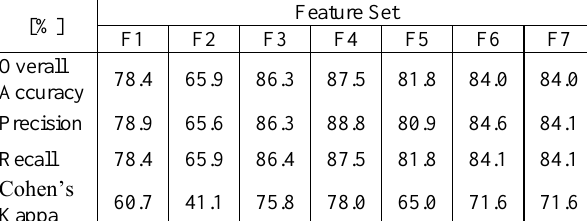
This contribution has been peer-reviewed. The double-blind peer-review was conducted on the basis of the full paper.